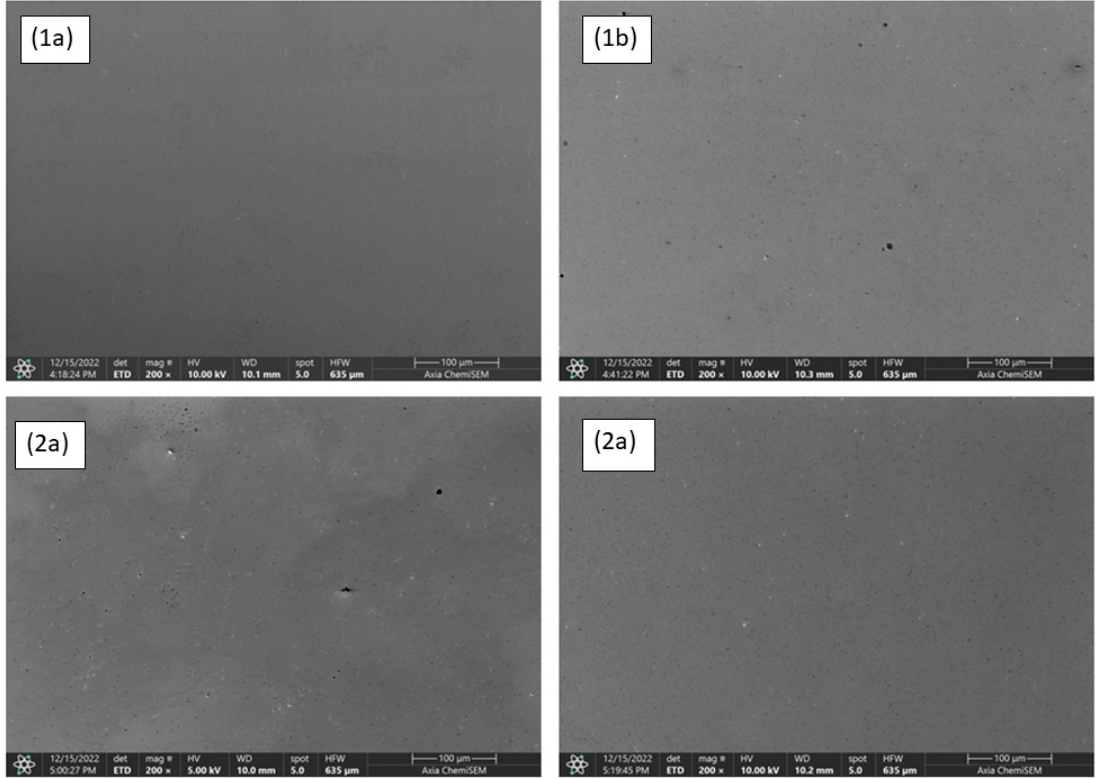
Figure 14. Microstructure of WC–9FeNi–1Cr 3 C 2 –0.5NbC sample ( 1a ) before and ( 1b ) after corrosion and sample WC–9FeNiCo–1Cr 3 C 2 –0.5NbC ( 2a ) before and ( 2b ) after corrosion.